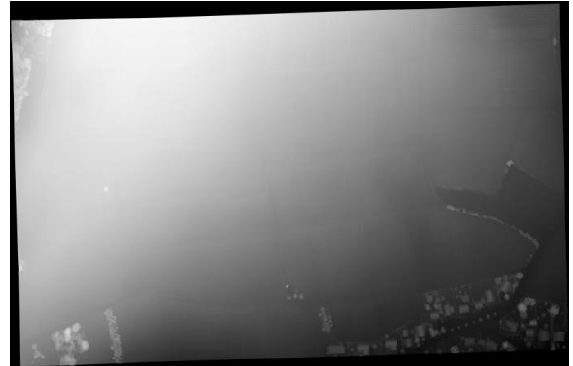
Figure 2. The screenshot shows the DSM of test-area 2 created from the nadir camera only as a take-off from the OIS-L, the screenshot below the DSM from the OIS-L.